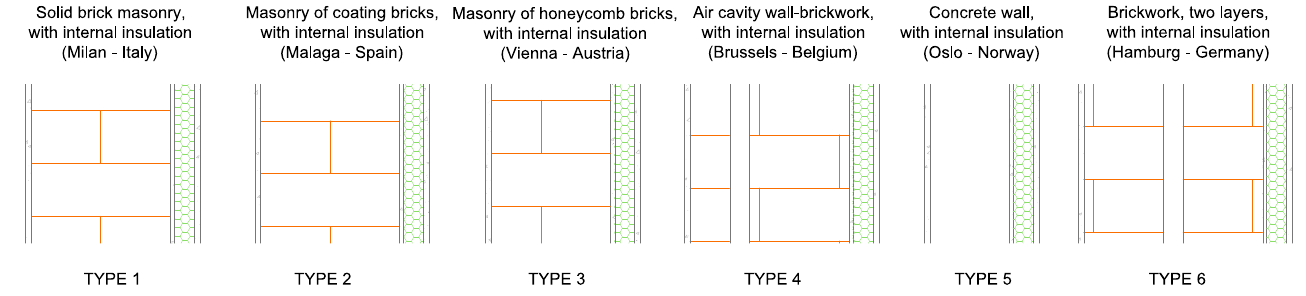
Figure 1. Types of wall stratigraphy determined by TABULA by reference location.